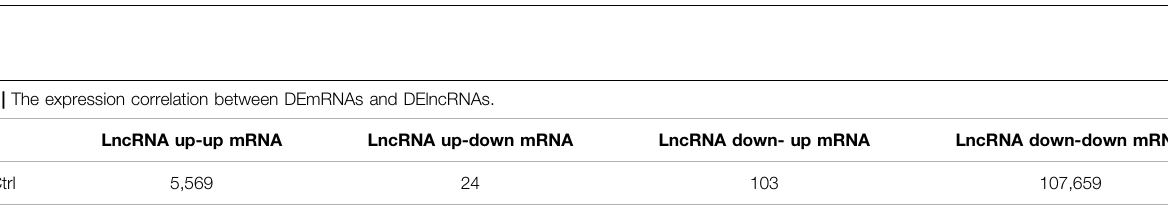
FIGURE 5 | DEmRNAs protein-protein interaction networks. (A) Network established from 551 DEmRNAs with adjusted p value < 1 × 10 − 5 , con fi dence score of 0.9. (B,C) Enriched GO and KEGG pathway of the interaction network. (D) The network constructed from the most signi fi cant 30 DEmRNAs, con fi dence score of